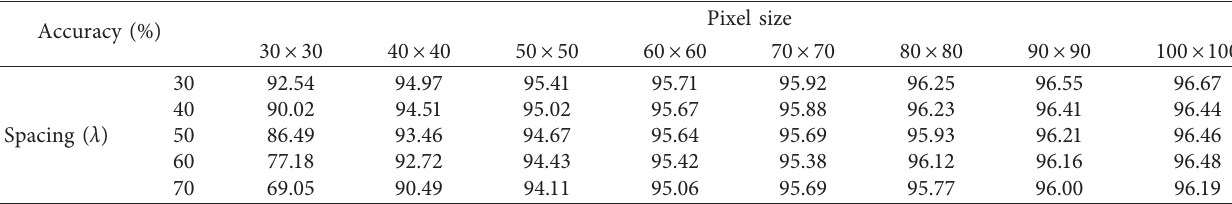
Table 8: The classification accuracy in the N-D 2 NN model adding the PReLU activation function corresponds to pixel size and diffraction grating spacing.